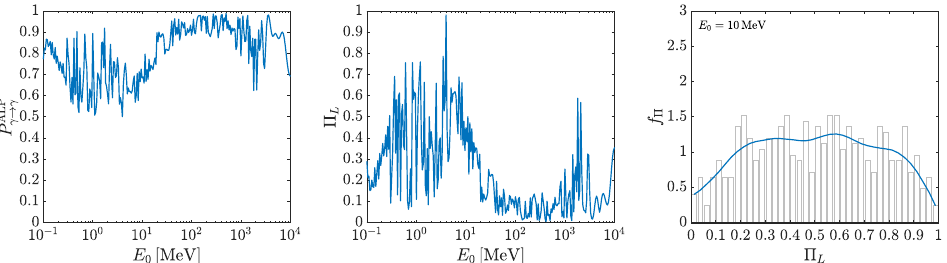
Figure 31. Photon survival probability in the presence of photon-ALP interaction P ALP γ → γ ( left panel ) and corresponding final degree of linear polarization Π L ( central panel ) with respect to the energy E 0 for photons produced at the blazar jet base. In the ( right panel ) the probability density function f Π of Π L at E 0 = 10MeV is reported. The initial degree of linear polarization is Π L ,0 = 0. See the text for the system parameter